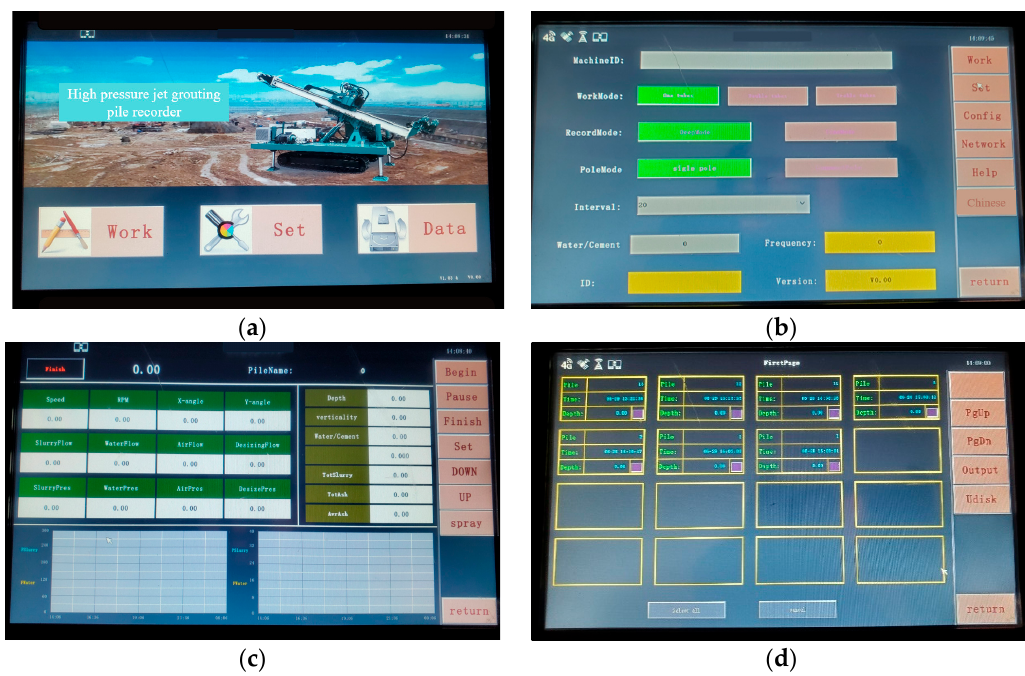
Figure 14. The operating system for the double fluid jet grouting system. ( a ) Interface. ( b ) Setup menu. ( c ) Working monitor. ( d ) Data history.